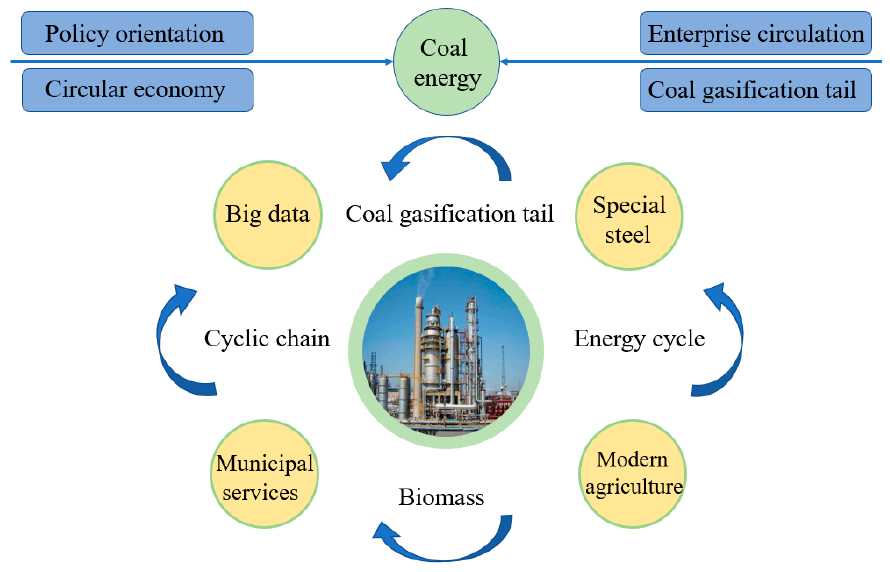
Figure 6. Green economy transformation model of coal energy-based cities.